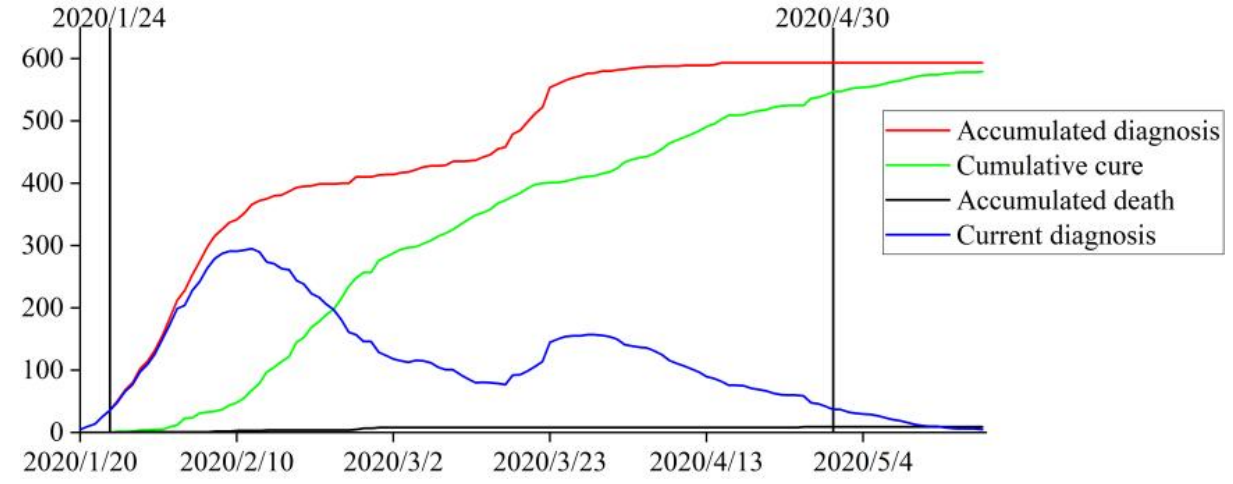
Figure 1. Temporal development of COVID-19 virus infection in Beijing.